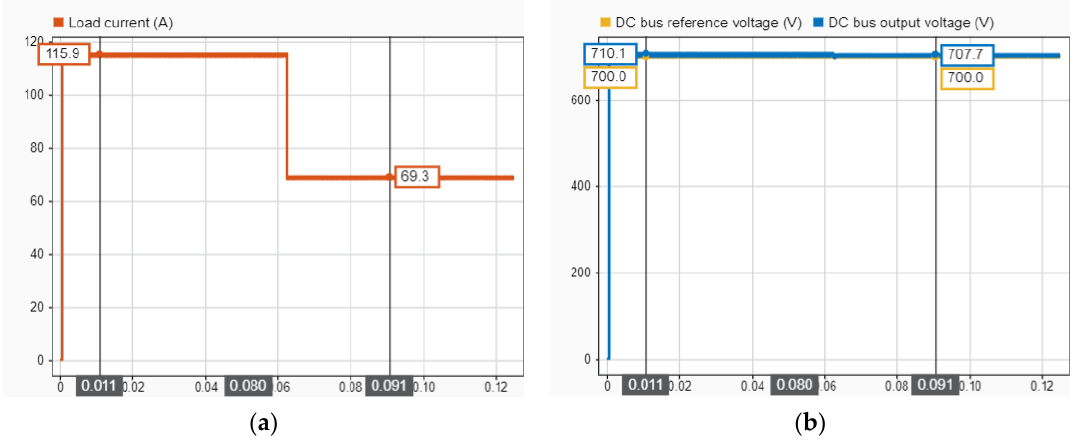
Figure 8. Load current and output voltage for the variation of the power load from 40 kW to 10 kW: ( a ) load current; ( b ) DC bus output